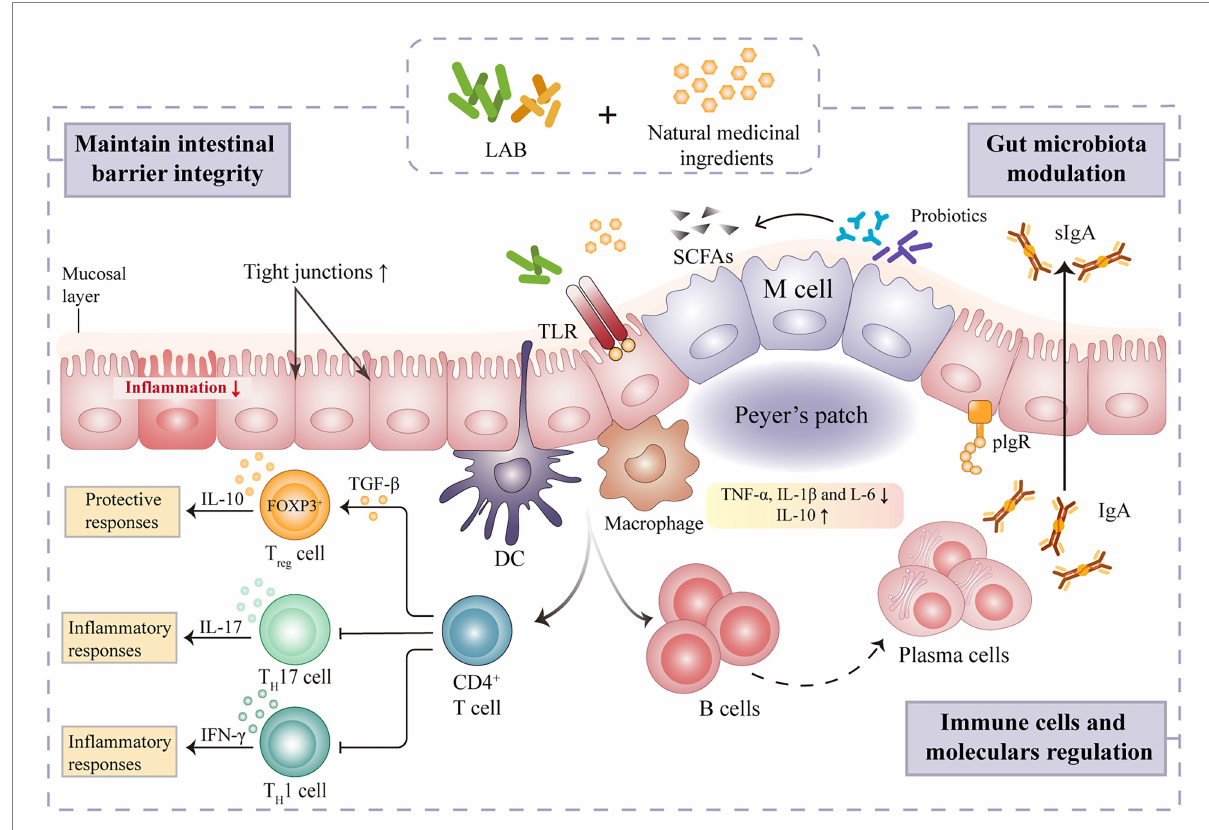
FIGURE 3 Mechanism of intestinal immune regulation of natural medicines fermented by lactic acid